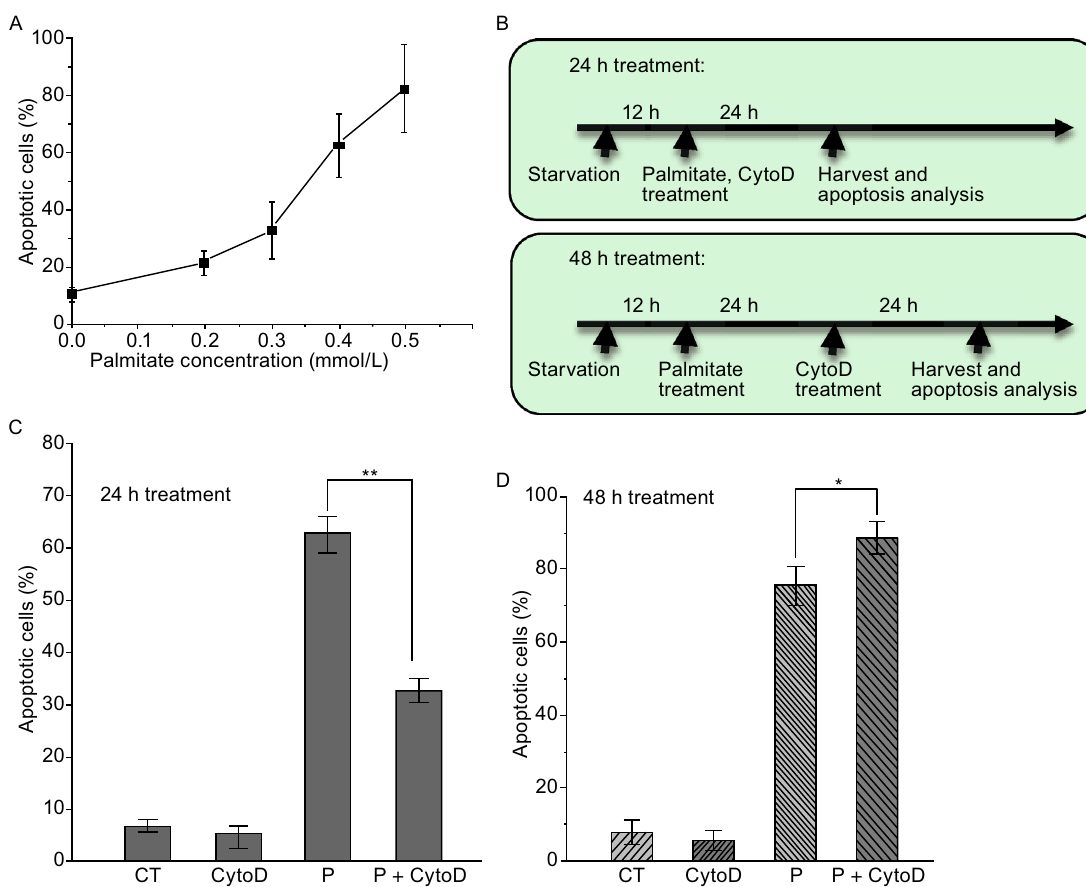
Figure 1. Palmitate induces β -cells apoptosis through F-actin remodeling. (A) Apoptosis of rat INS-1 832/13 cells was induced with palmitate at different concentrations for 24 h. Apoptotic cells were recognized as Annexin V-positive and PI-negative cells and quanti fi ed through fl ow cytometry. (B) Time lines along with speci fi c events for the 24-h and 48-h palmitate treatment procedures. (C) CytoD reduced palmitate-induced apoptosis under the 24-h treatment as quanti fi ed with the Annexin V assay. (D) CytoD slightly enhanced palmitate-induced apoptosis under the 48-h treatment. In (C) and (D), fi nal concentrations of palmitate (0.3 mmol/L) and CytoD (0.5 µmol/L) were used, and data show the mean ± SD of four independent experiments. CT: Control; CytoD: Cytochalasin D; P: Palmitate. Ethanol (solvent of palmitate) and DMSO (solvent of CytoD) were used in the control experiments. “ * ” and “ ** ” indicate P < 0.05 and P < 0.01, respectively, by Student ’ s t